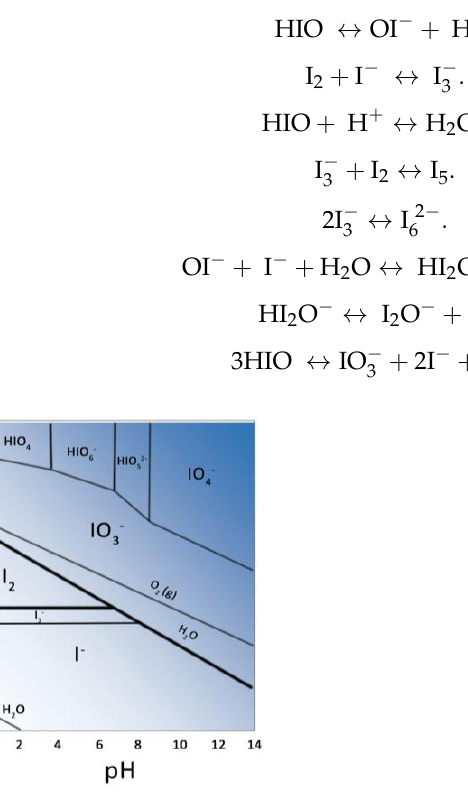
Figure 2. Iodine speciation in aqueous systems. Pourbaix diagram of iodine depicting species stability by pH and Eh [26]. Abbreviations: pH, potential of hydrogen; Eh, redox potential (measured in volts).